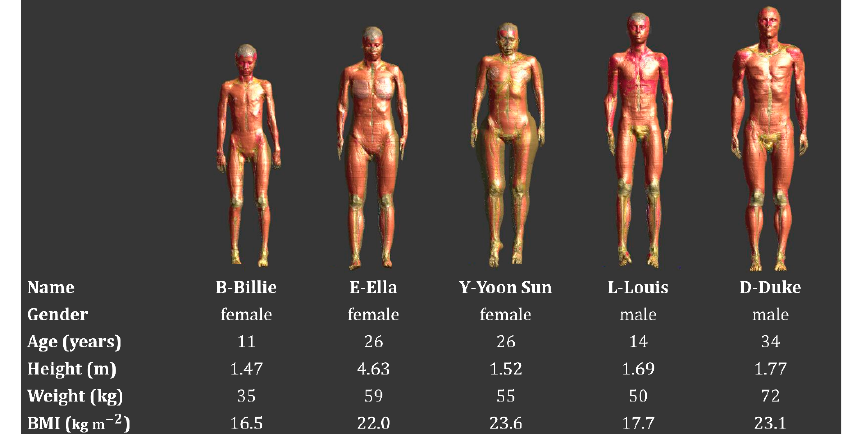
Figure 1. Representation of the virtual family models used (Billie, Ella, Yoon Sun, Louis, and Duke) together with the characteristics of each model (age, height, weight, and BMI: body mass index).